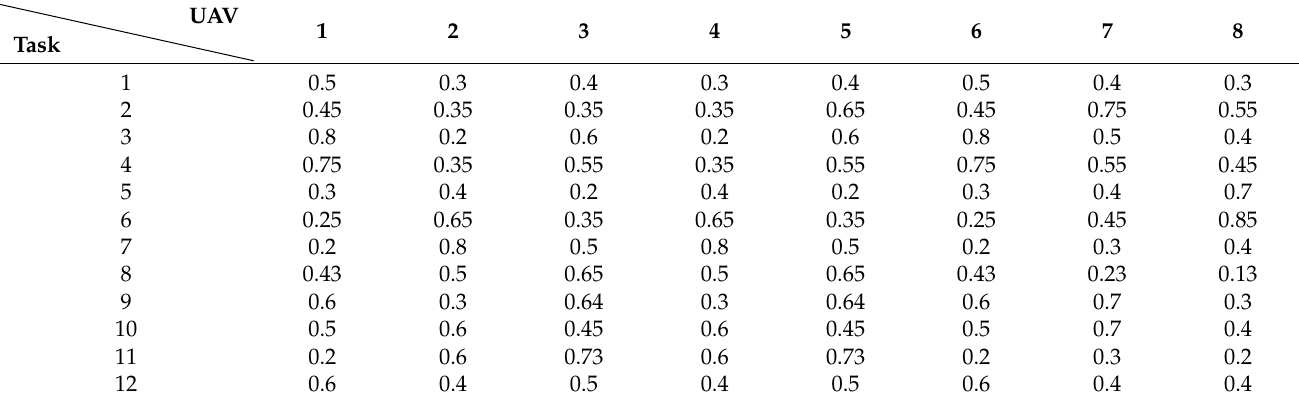
Table 5. UAV stealth capability information.